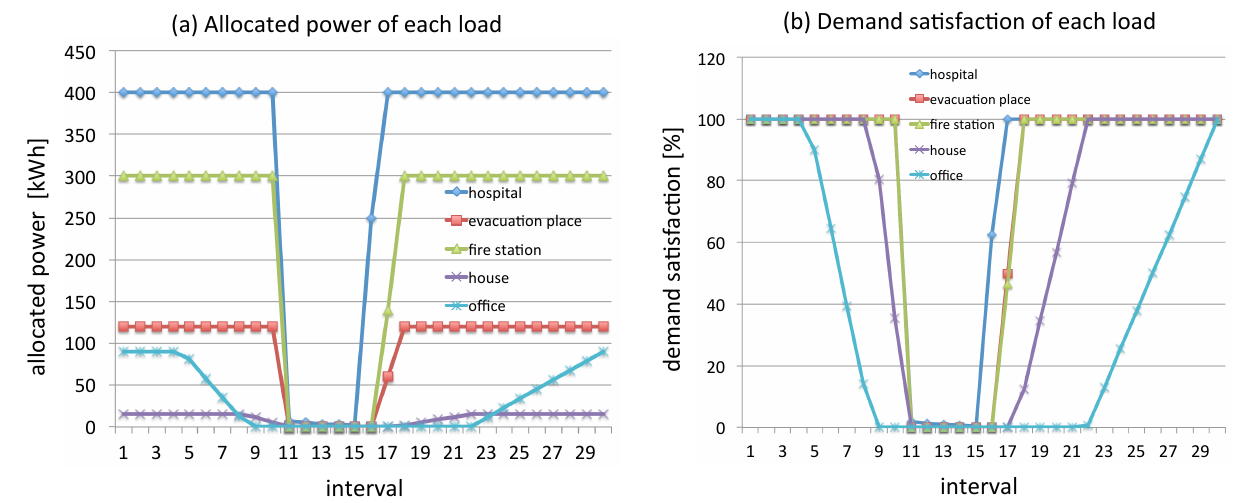
Figure 14. Allocated power and demand satisfaction.